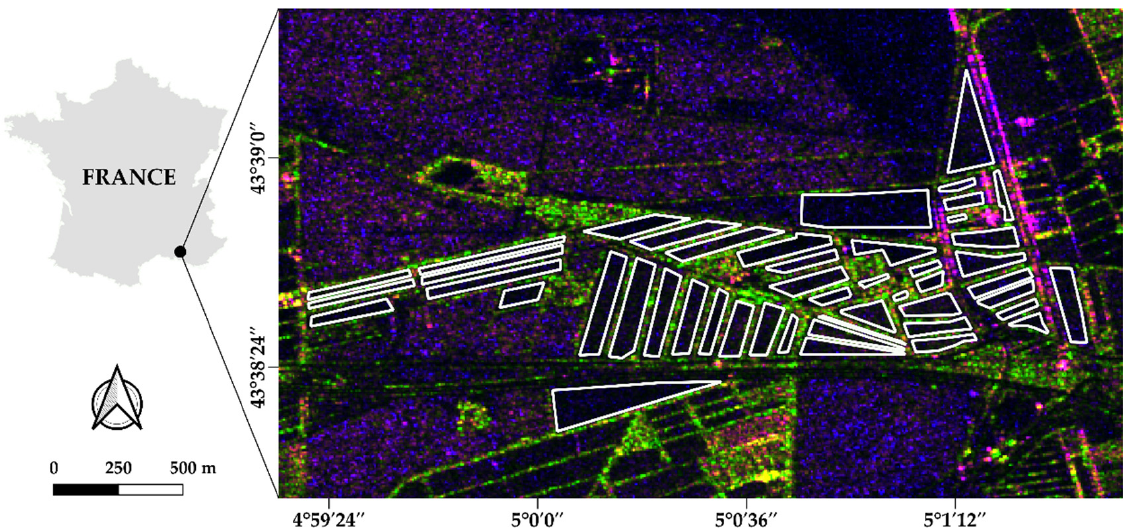
Figure 1. Location of the study site (Crau Plain). White polygons delineate the 45 irrigated grassland plots. The background is an RGB composite color of the ALOS-2 L-band SAR image acquired on 21 May 2019 (R: HH, G: HV and B: HH/HV).